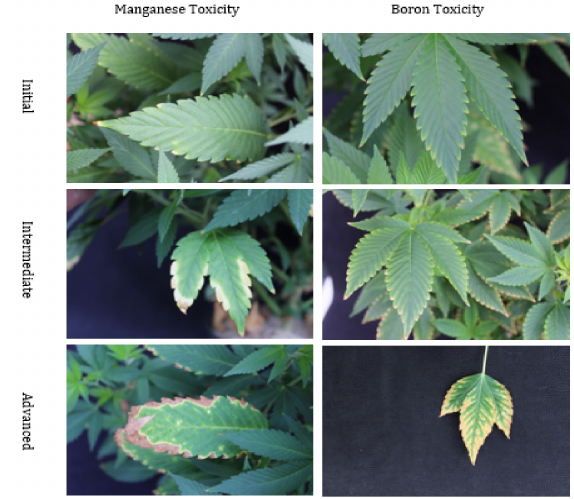
Figure 5. Nutritional disorders of manganese toxicity (Mn) and boron toxicity (B) in Cannabis sativa ‘T1’ plants. These pictures display the symptomological progression of nutritional orders as they progress from initial, intermediate, and